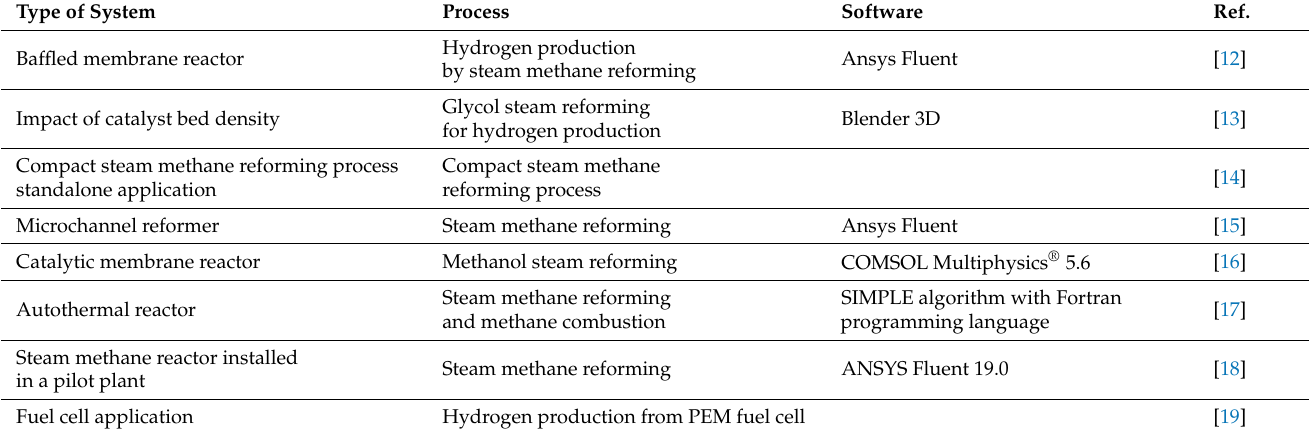
Table 1. List of the main CFD simulation of the steam reforming for hydrogen